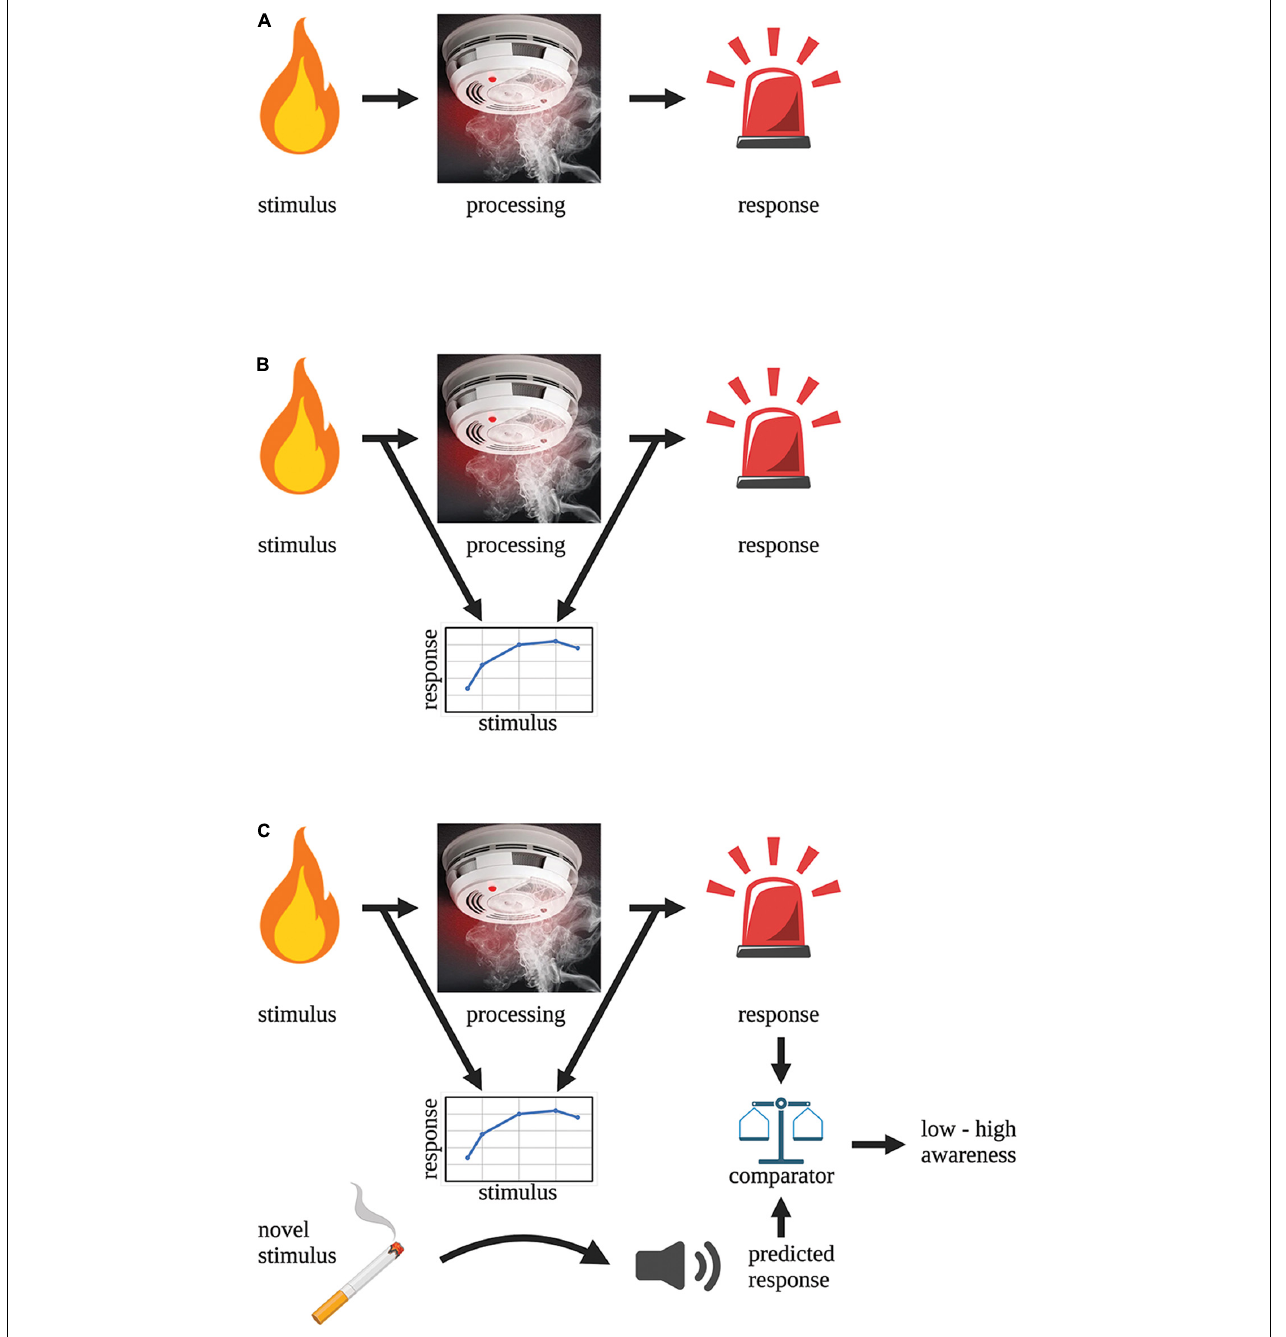
FIGURE 1 | Building “awareness” into a circuit. (A) A fire alarm circuit is an example of a simple stimulus-detection (processing)-response circuit that lacks awareness. (B) The addition of an external monitoring circuit enables the system to learn the relationship between the stimulus and the response. This monitoring circuit lies external to the processing pathway that is being monitored. (C) The addition of a comparator module to the circuit allows the predicted response to be compared to the real response. The accuracy of the prediction is a measure of the “awareness” of the system.